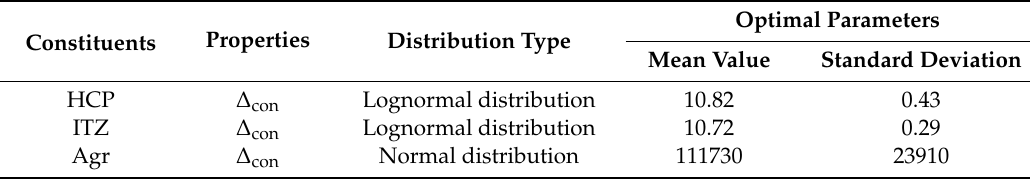
Table 1. Optimal parameters for the 1D PDF.